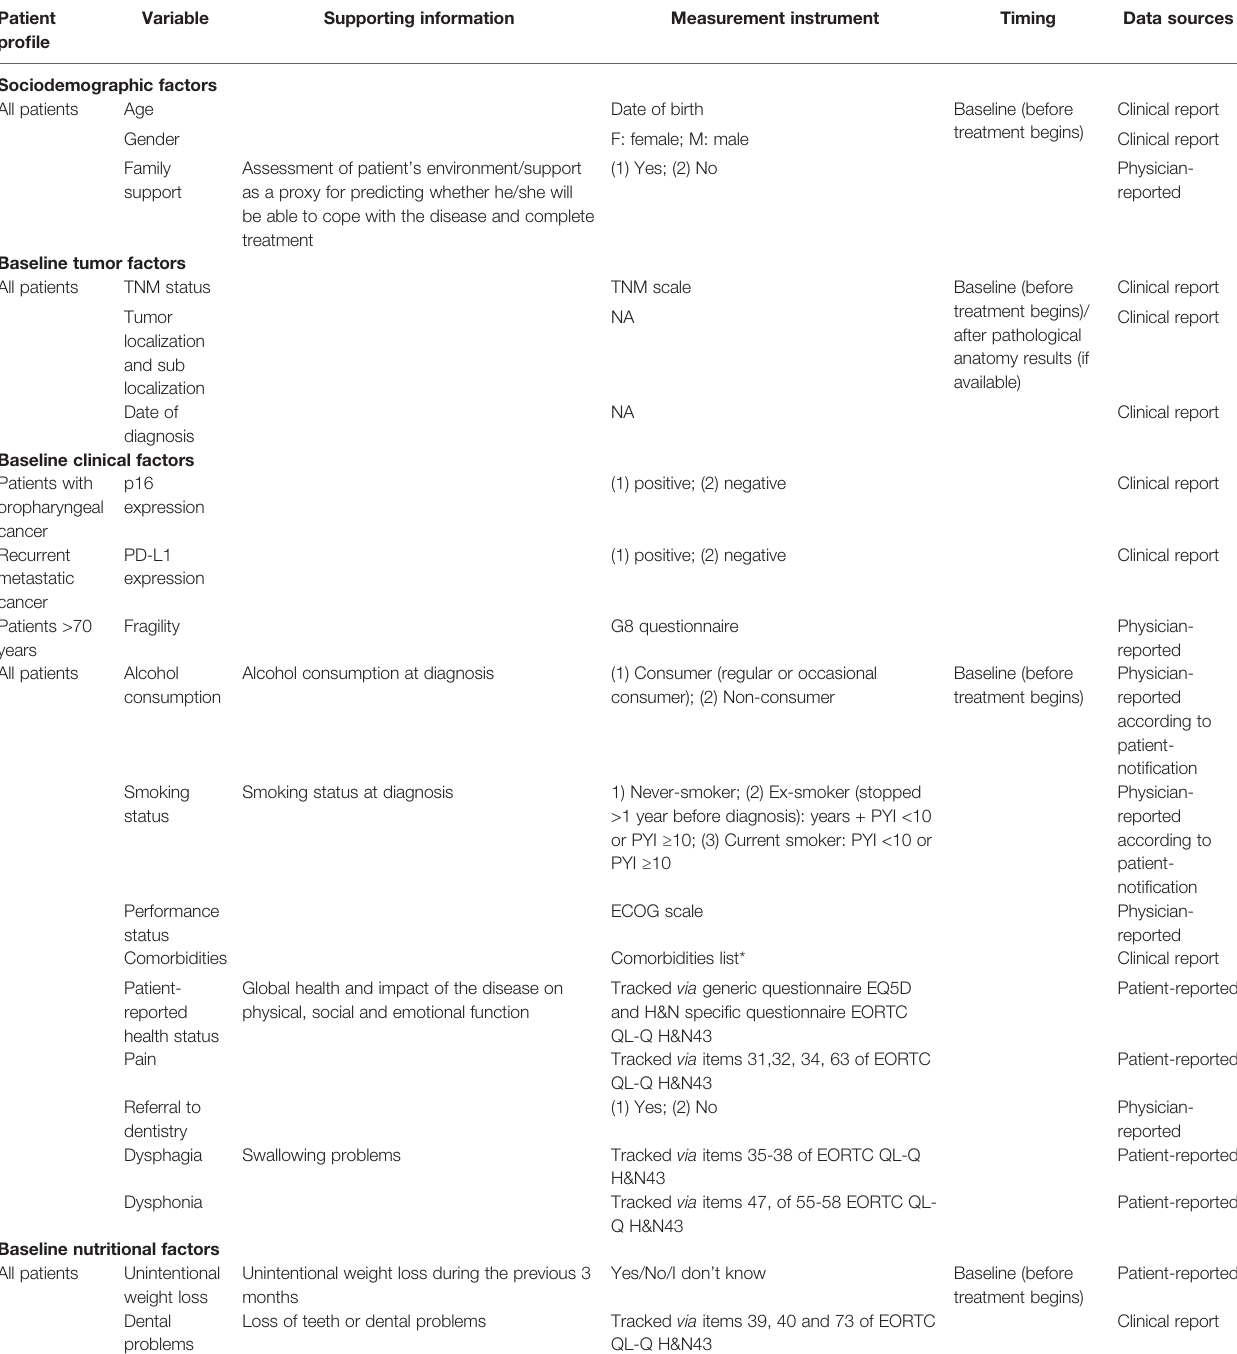
TABLE 1 | Spanish standard set of patient-centered outcomes in